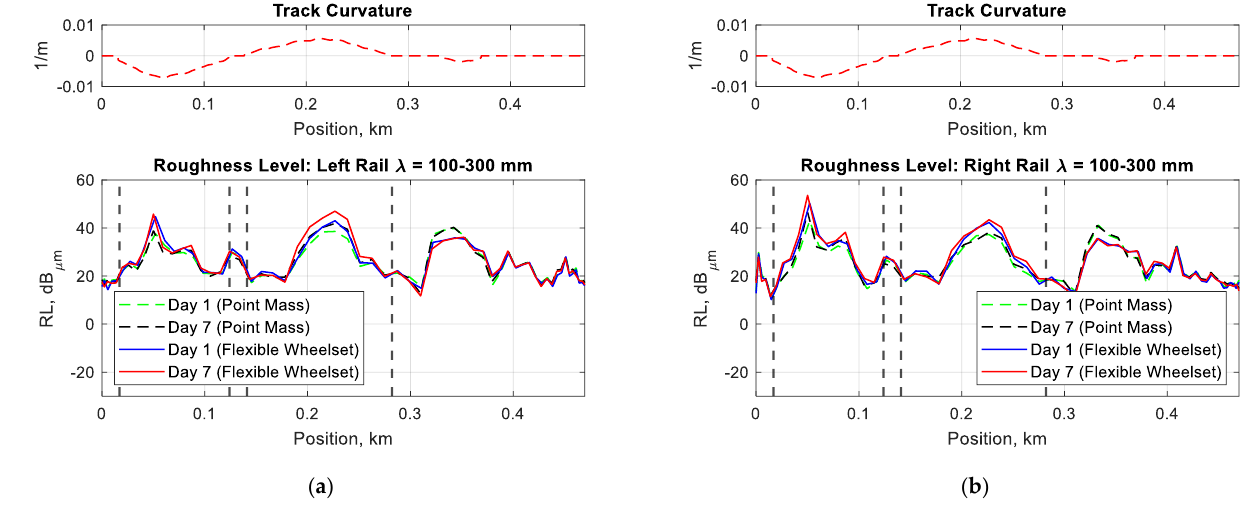
Figure 12. Roughness Level in the 100–300 mm wavelength band: ( a ) left rail; ( b ) right rail.